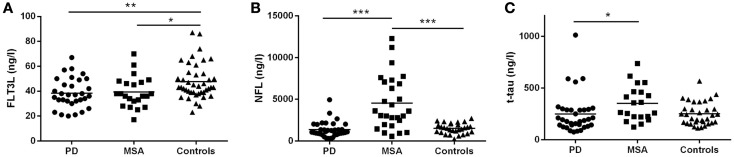
Cerebrospinal fluid concentrations of FLT3L, NFL, and t-tau for the MSA, PD, and control groups: discovery cohort. (A) FLT3L levels are significantly reduced in MSA and PD as compared to controls. NFL (B) and t-tau (C) concentrations are significantly increased in the MSA group compared with the PD group. MSA, multiple system atrophy; PD, Parkinson’s disease; NS, non-significant difference; mean values are indicated by horizontal lines.